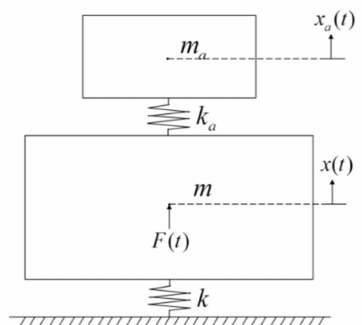
Figure 4. Modeling of single degrees of freedom vibration absorber and target structure.